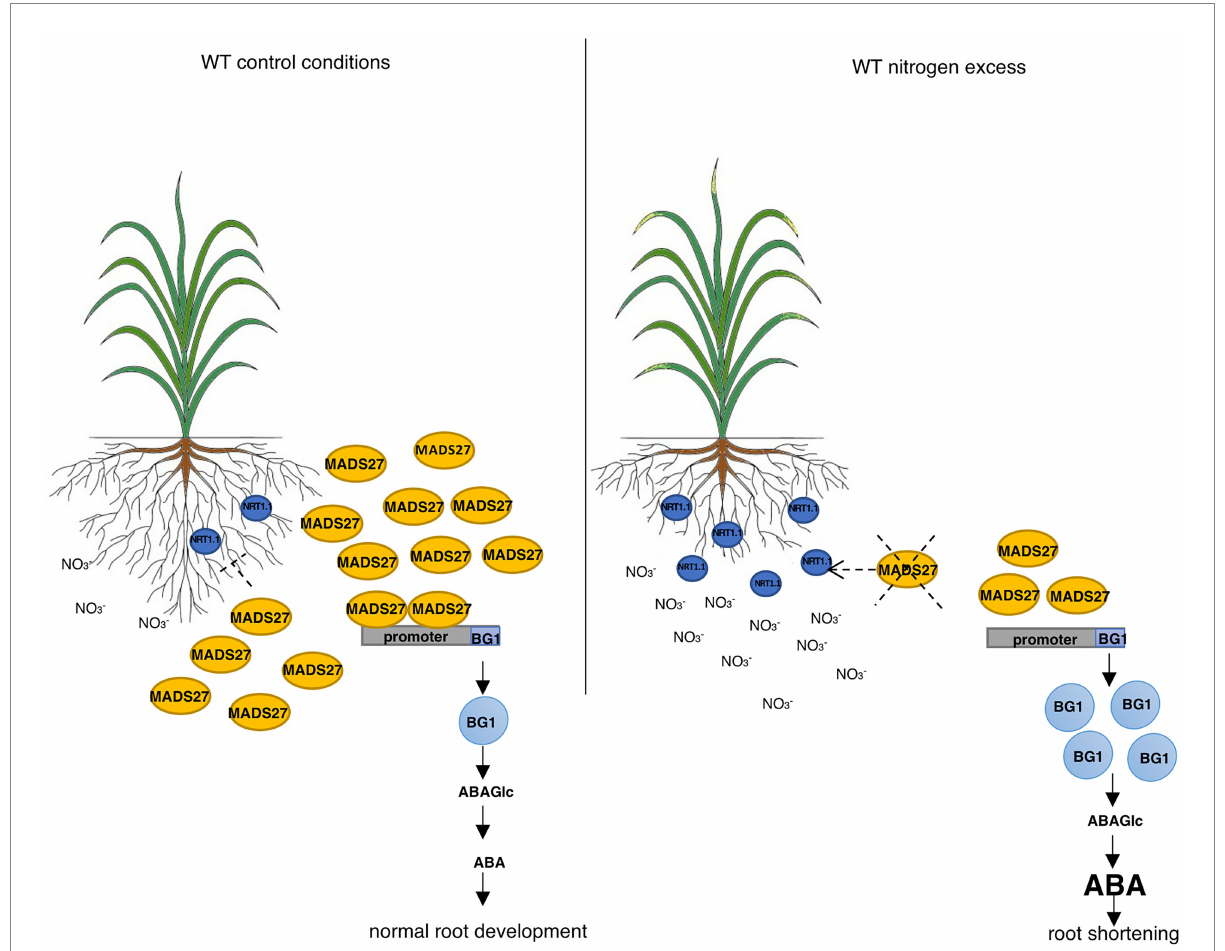
FIGURE 7 HvMADS27 regulates barley roots response to excess N stress. HvMADS27 regulated barley root response under excess N stress. Increased N concentration in the rhizosphere activates N sensor and transporter NRT1.1, which provides N influx to the root cells. High N concentration downregulates the expression of HvMADS27 , which relieves the inhibition of HvBG1 glucosidase expression. HvBG1 is activated and catalyzes the release of ABA from the ABA-glucose conjugate, which causes an increase in ABA levels and shortening of the barley